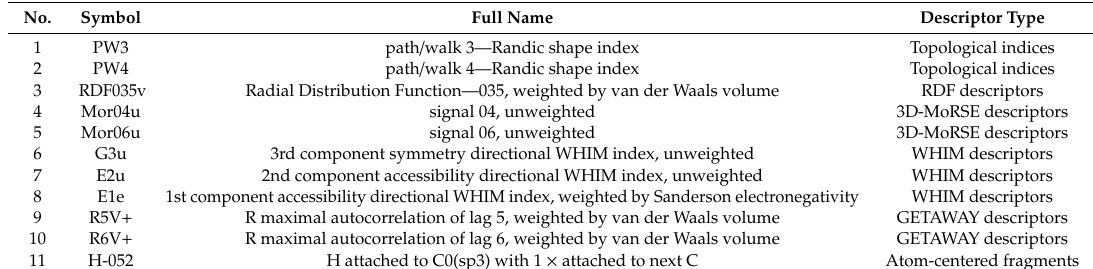
Table 2. List of molecular descriptors selected by the DE-PLS model.